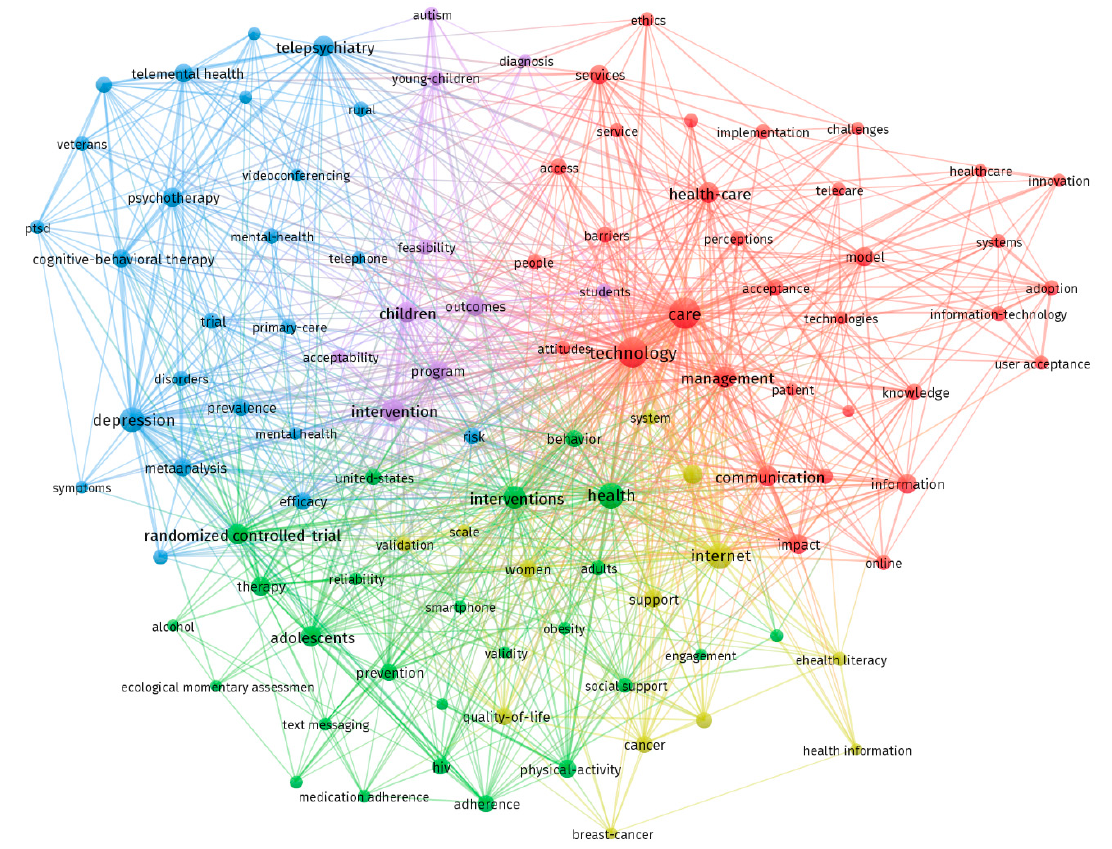
Figure 6. Cluster visualization of co-occurrence of keywords.